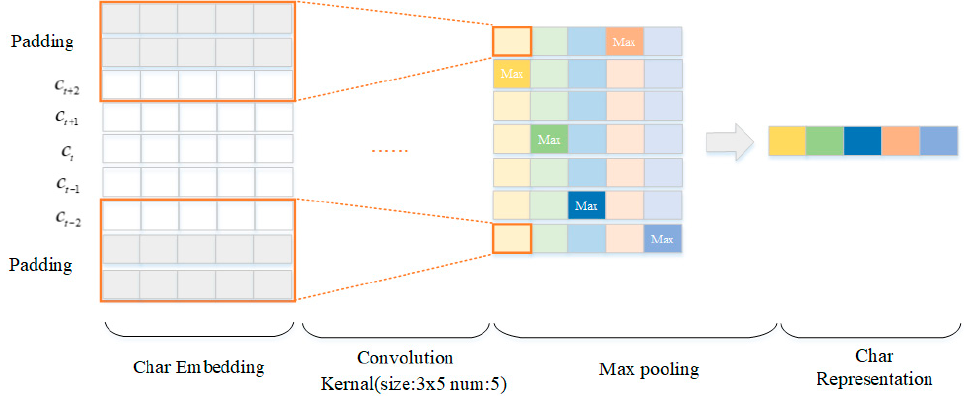
Figure 2. CNN extracts character-level features.